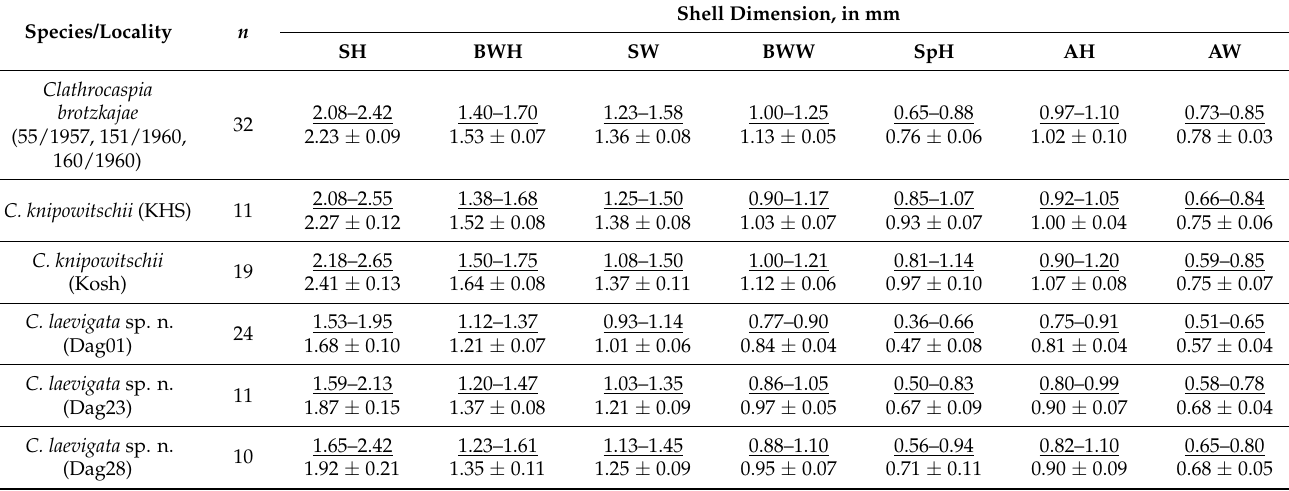
Table 2. The morphometric characteristics of shells of the Clathrocaspia species discussed in this study. Above lines—min–max values; below lines—mean value ± SD. Abbreviations according to Figure